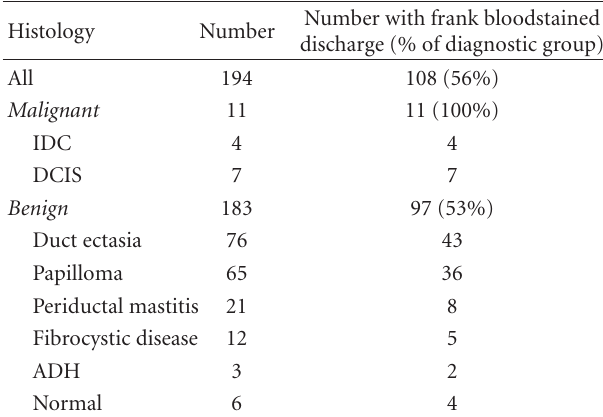
Table 3: Histology compared to type of